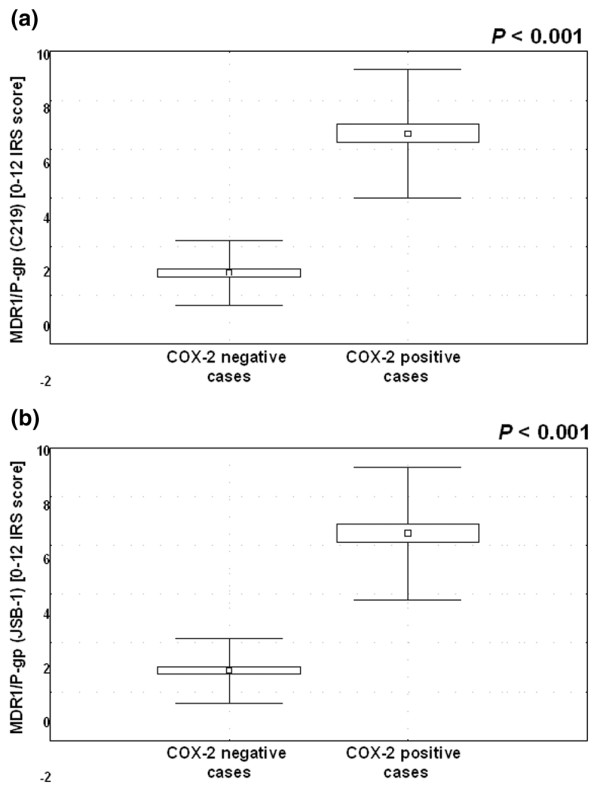
Correlation between cyclooxygenase-2 (COX-2) and MDR1/P-glycoprotein (MDR1/P-gp) expression. (a) Correlation between COX-2 and MDR1/P-gp expression detected with antibody C219. (b) Correlation between COX-2 and MDR1/P-gp expression detected with antibody JSB-1 in breast cancers. Cases with COX-2 expression show higher MDR1/P-gp expression (ANOVA Kruskall-Wallis rank test, P < 0.001).